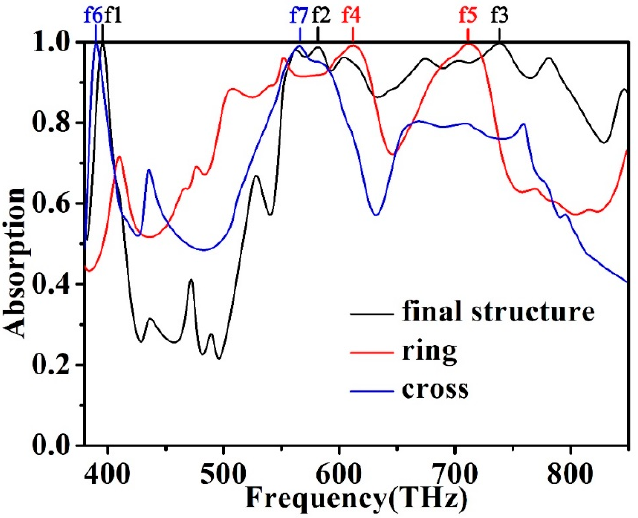
Figure 10. The absorption of the ring, the cross, and the final structure .